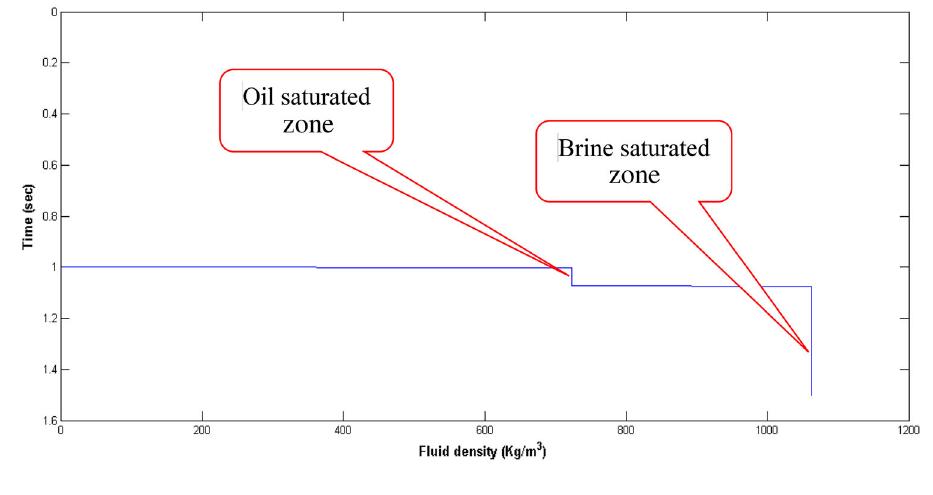
Fig. 16 Fluid velocity plot with 30% porosity of Arab